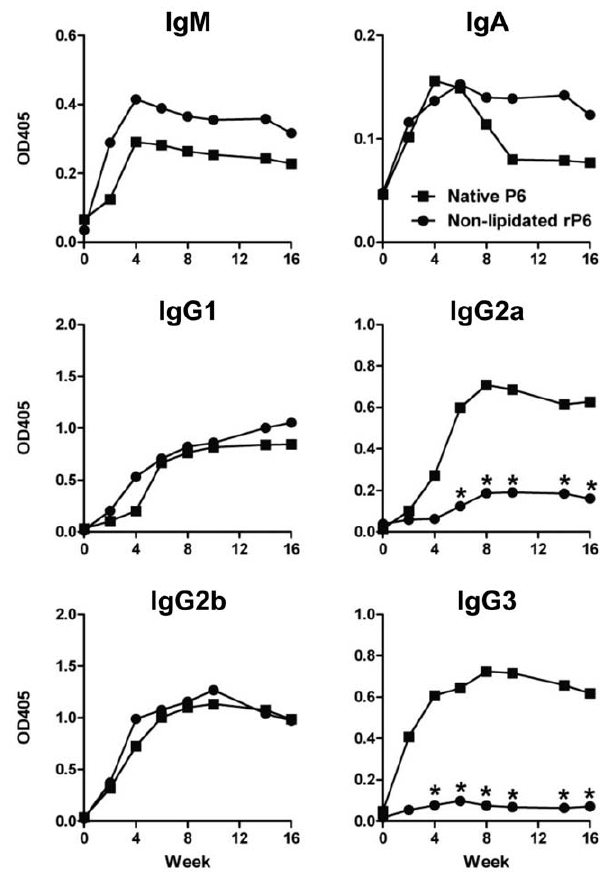
Figure 2. Anti-P6 Ig isotype and subclass analysis in immu- nized mice. Levels of Ig isotype and IgG subclass were measured by N ELISA in WT mice immunized with native P6 ( & ) or non-lipidated rP6 ). OD values at 405 nm for sera dilutions at 10 2 2.6 (1:400) were ( analyzed for levels of P6-specific IgA, IgM, IgG1, IgG2a, IgG2b, and IgG3. *p , 0.05 2way ANOVA with Bonferroni post-test comparison between native P6 and non-lipidated rP6 at each timepoint.